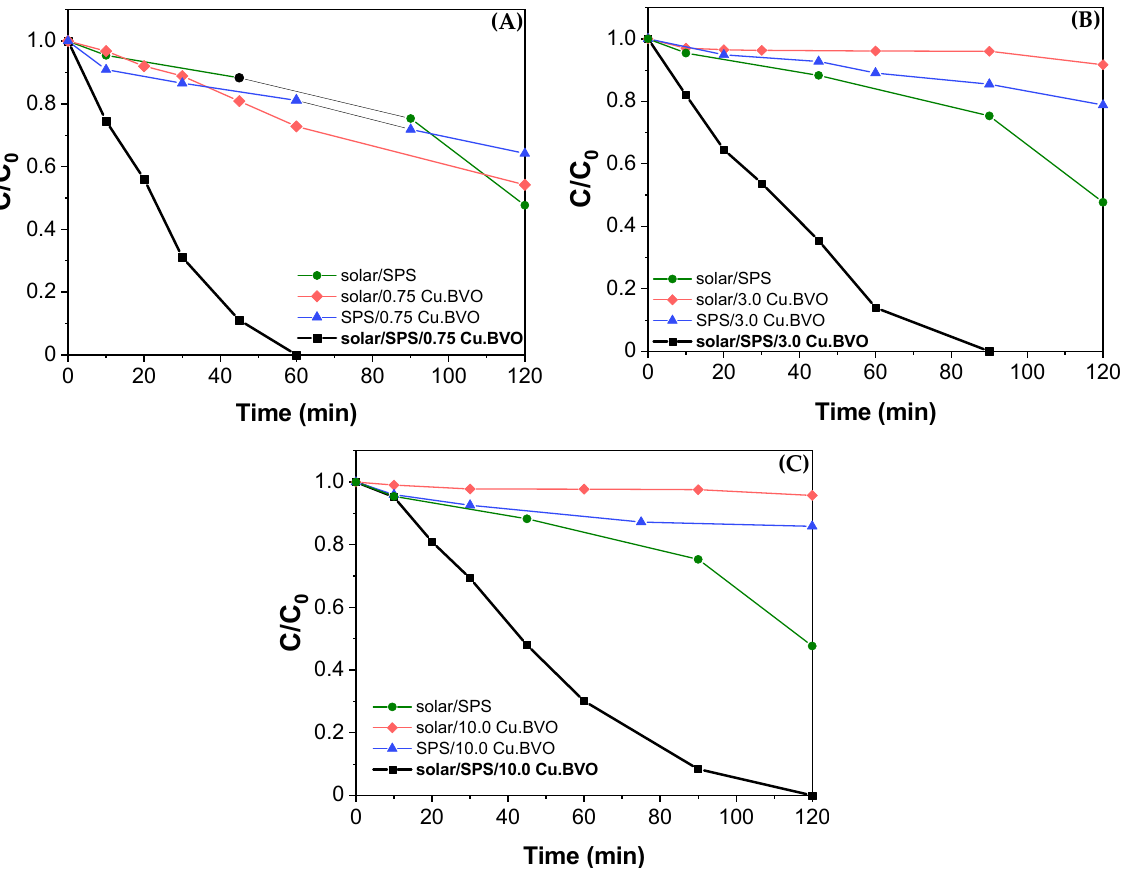
SMX degradation profiles in BW under solar/SPS, solar/0.75 Cu.BVO, SPS/0.75 Cu.BVO, and solar/SPS/0.75 Cu.BVO systems are shown in Figure 7A. In the presence of only 100 mg/L SPS under simulated solar irradiation, 40% SMX degradation was observed after 120 min, showing the limited activation of SPS by sunlight. Similar SMX removal was recorded in the solar/0.75 Cu.BVO system. Furthermore, 0.75 Cu.BVO showed restricted activity as a SPS activator, resulting in only 30% SMX removal in the same period. However, when 0.75 Cu.BVO and SPS were added to the system, complete 0.5 mg/L SMX degradation was obtained in 60 min. The synergy, as quantified by Equation (2), was 75%. Qualitatively similar results were recorded for the 3.0 Cu.BVO sample.